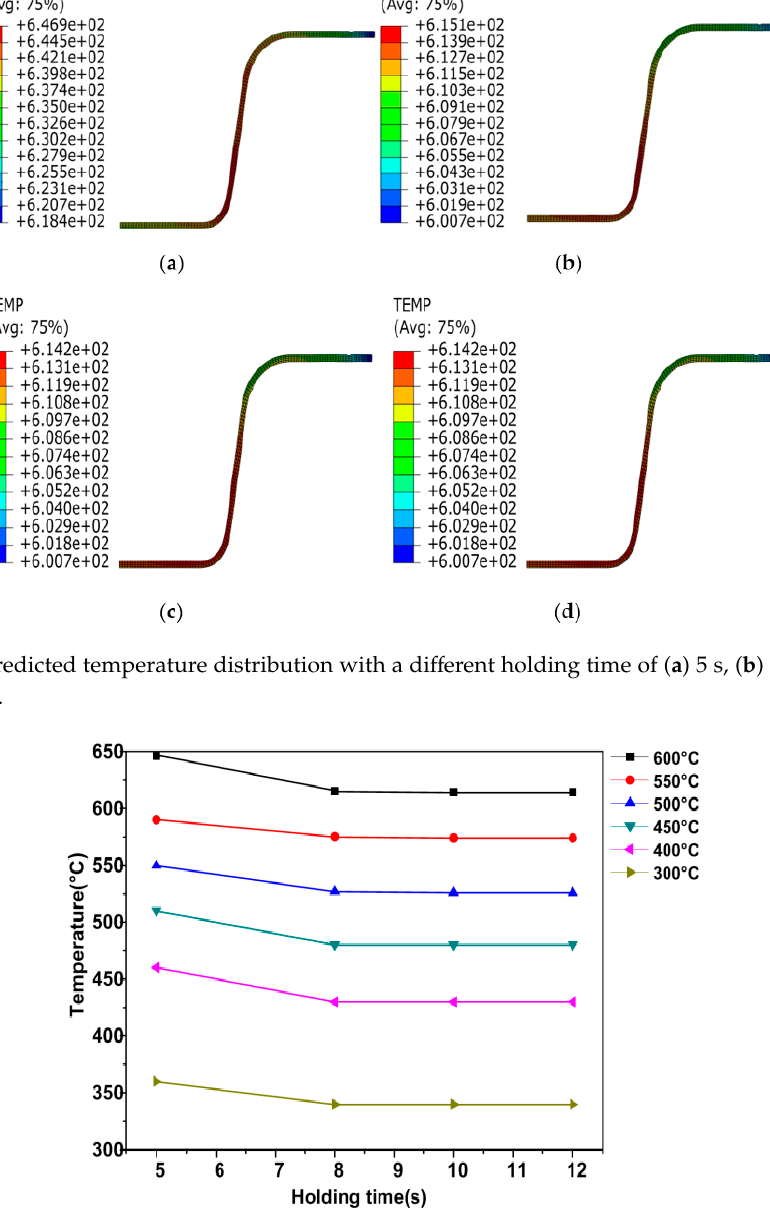
Figure 4. The relationship between the predicted maximum temperature of the as-quenched blank the holding time at di ff erent die and the holding time at different die temperatures.